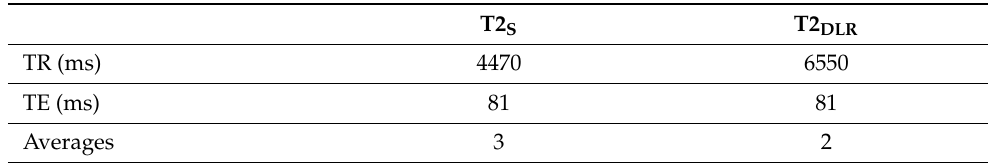
Table 1. MRI acquisition